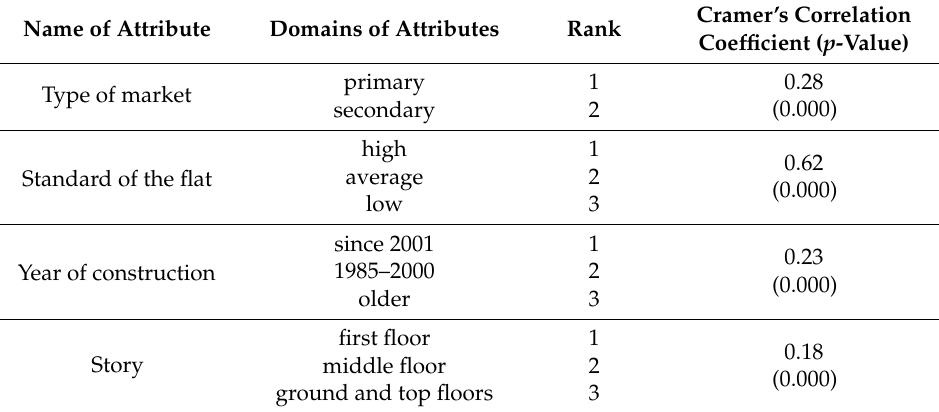
Table 2. Property attributes analyzed.